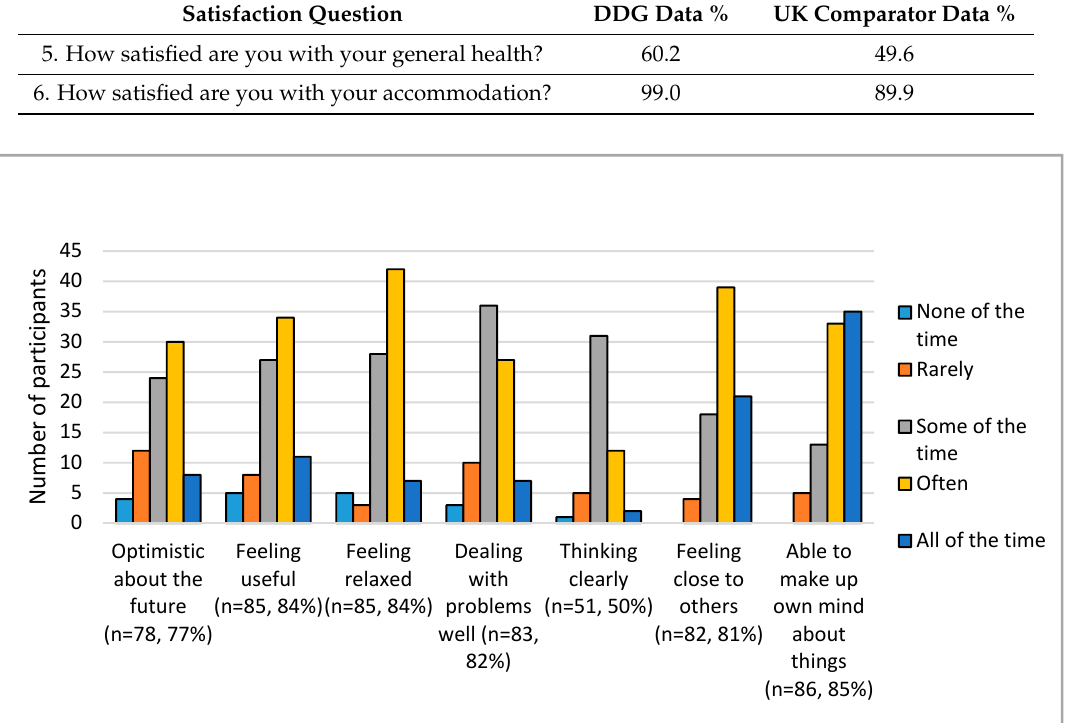
Figure 1. Baseline participant scores for mental wellbeing based on the Short Warwick Edinburgh Mental Wellbeing Scale.